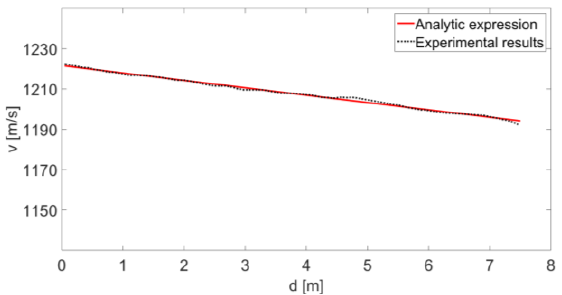
Figure 9. Illustration of the distance between the moving target to the radar r and the initial point d .